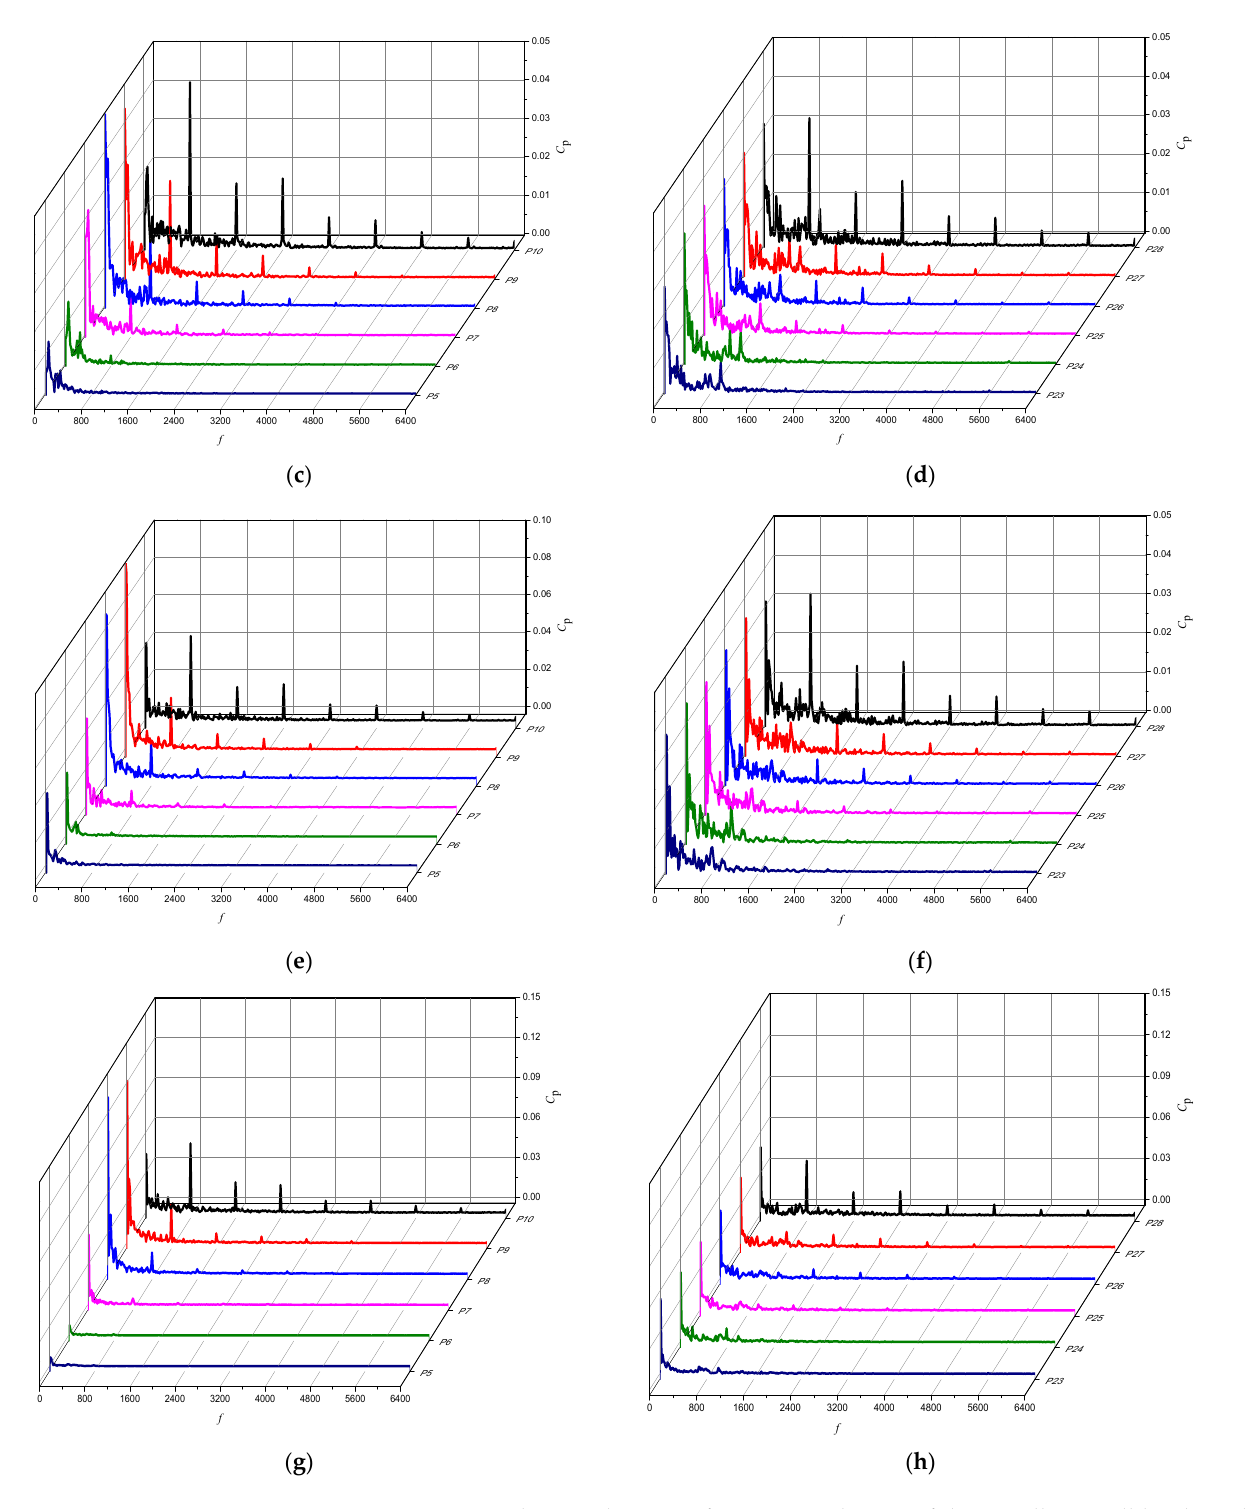
Figure 12. Frequency domain diagram of pressure pulsation of the impellers at all levels under cavitation conditions. ( a ) Primary impeller ( NPSH a = 11 m); ( b ) secondary impeller ( NPSH a = 11 m); ( c ) primary impeller ( NPSH a = 9 m); ( d ) secondary impeller ( NPSH a = 9 m); ( e ) primary impeller ( NPSH a = 7 m); ( f ) secondary impeller ( NPSH a = 7 m); ( g ) primary impeller ( NPSH a = 4 m) and ( h ) secondary impeller ( NPSH a = 4 m).